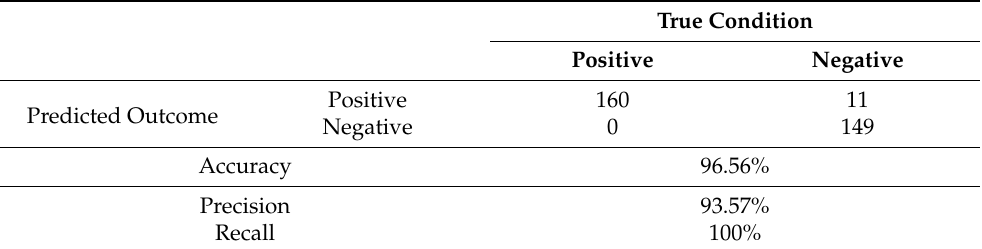
Table 5. Confusion matrix of the defect result with